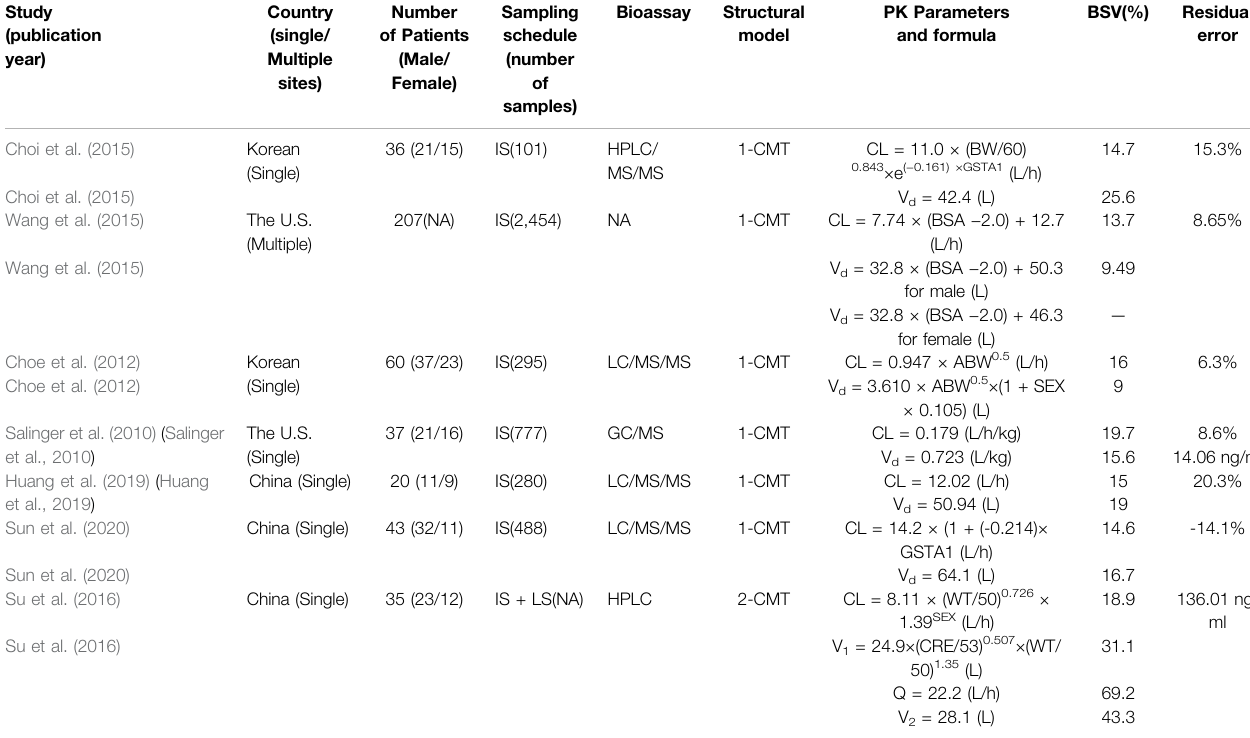
TABLE 2 | Summary of published population pharmacokinetic studies of busulfan in adult hematopoietic stem cell transplantation